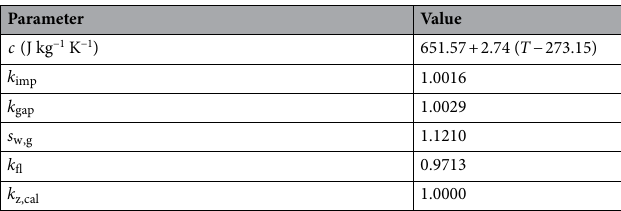
Table 1. Values of the specific heat capacity of graphite, c , as a function of temperature T in Kelvin, as well as the correction factors determined for the NPL PSPC for a field of 12 × 5 cm 2 at a water-equivalent depth of 5.2 g cm −2 .